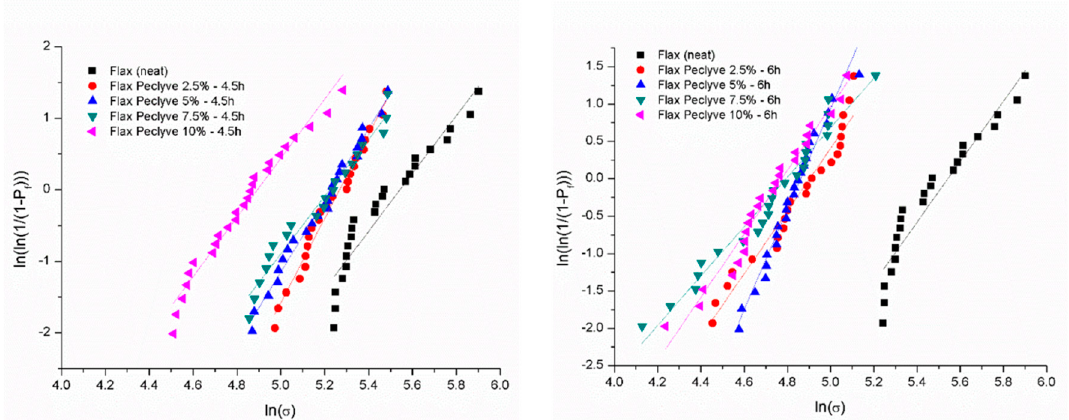
Figure 8. Weibull distribution plots of strength measured for neat flax yarns and enzymatically modified flax yarns for a duration of 4.5 h and 6 h.